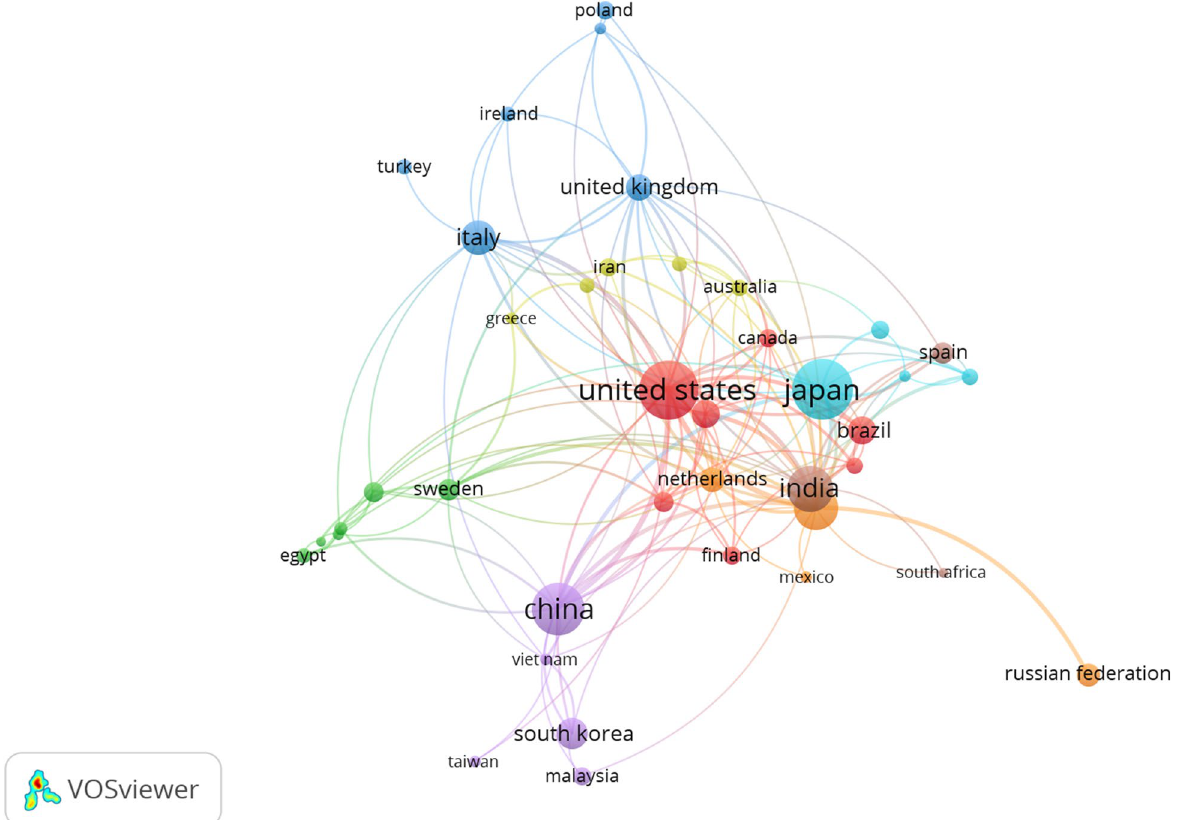
Fig. 4 Collaborative networks between the 20 most productive countries in the research of thermostable enzymes according to a bibliometric analysis of the Scopus